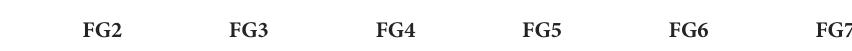
TABLE 3 Factor loadings of the food groups (FG) (N = 358).